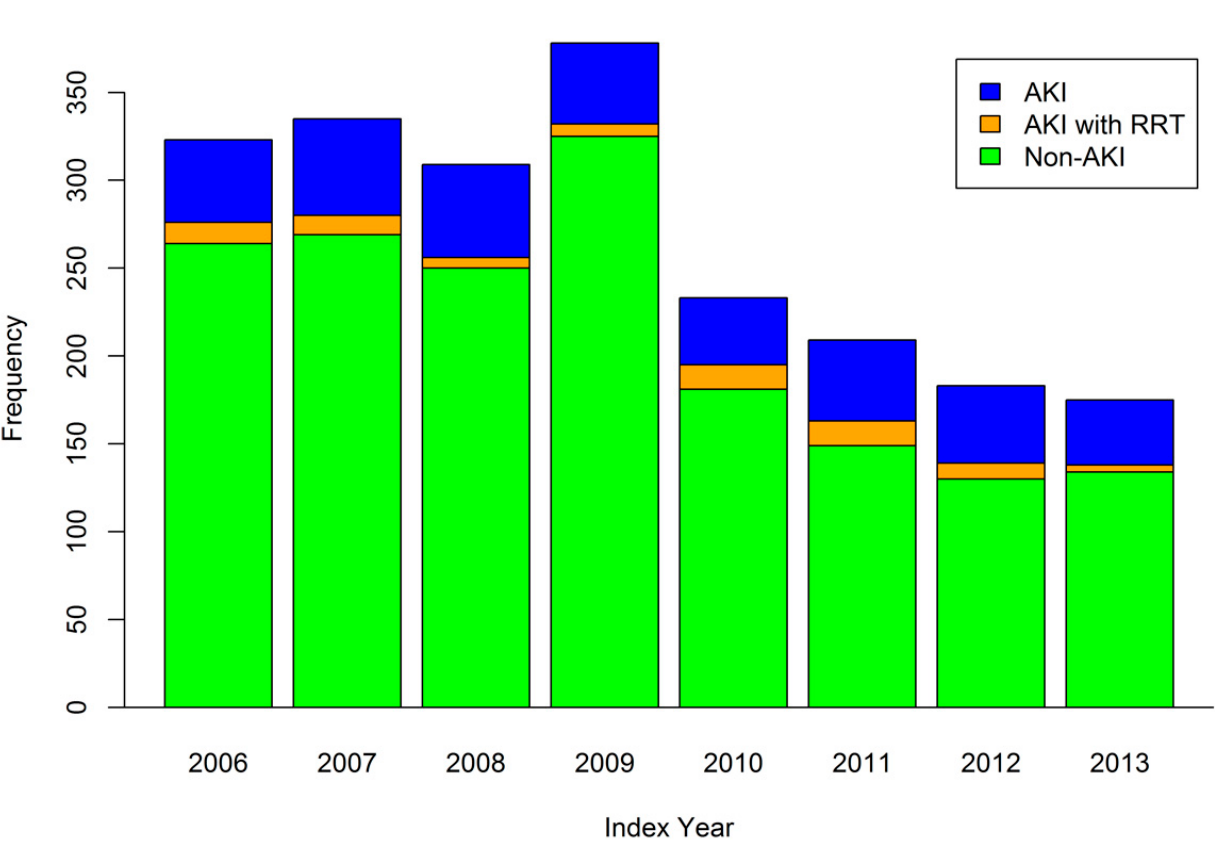
Figure 3. Distribution of the study groups by index year. Table 2. Number and percentage of event of